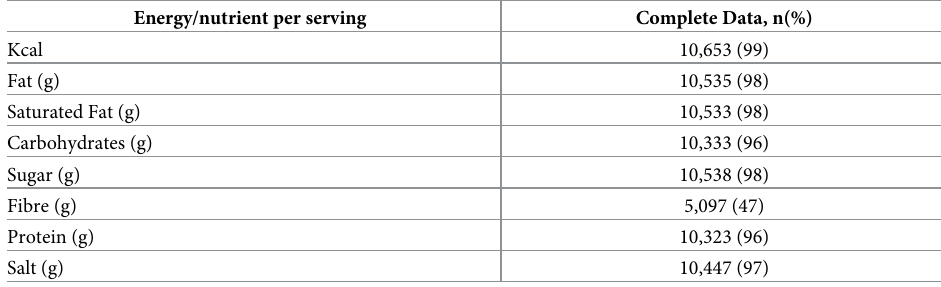
Table 3. Summary of non-missing data on energy and nutritional content of 10,782 menu